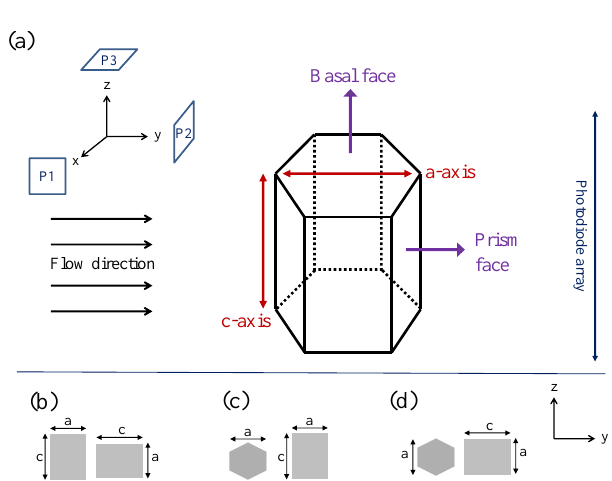
Figure B1. (a) Three-dimensional geometry of a hexagonal prism, representative of small ice crystals. Assuming that the direction of view (beam direction) is along the x axis, P1 is orthogonal to x axis, P2 is orthogonal to y axis, and P3 is orthogonal to z axis. Also shown is the projection of a hexagonal prism for three extremes, when its c axis is parallel to (b) P1, (c) P2, and (d) P3. See text for the definition of various